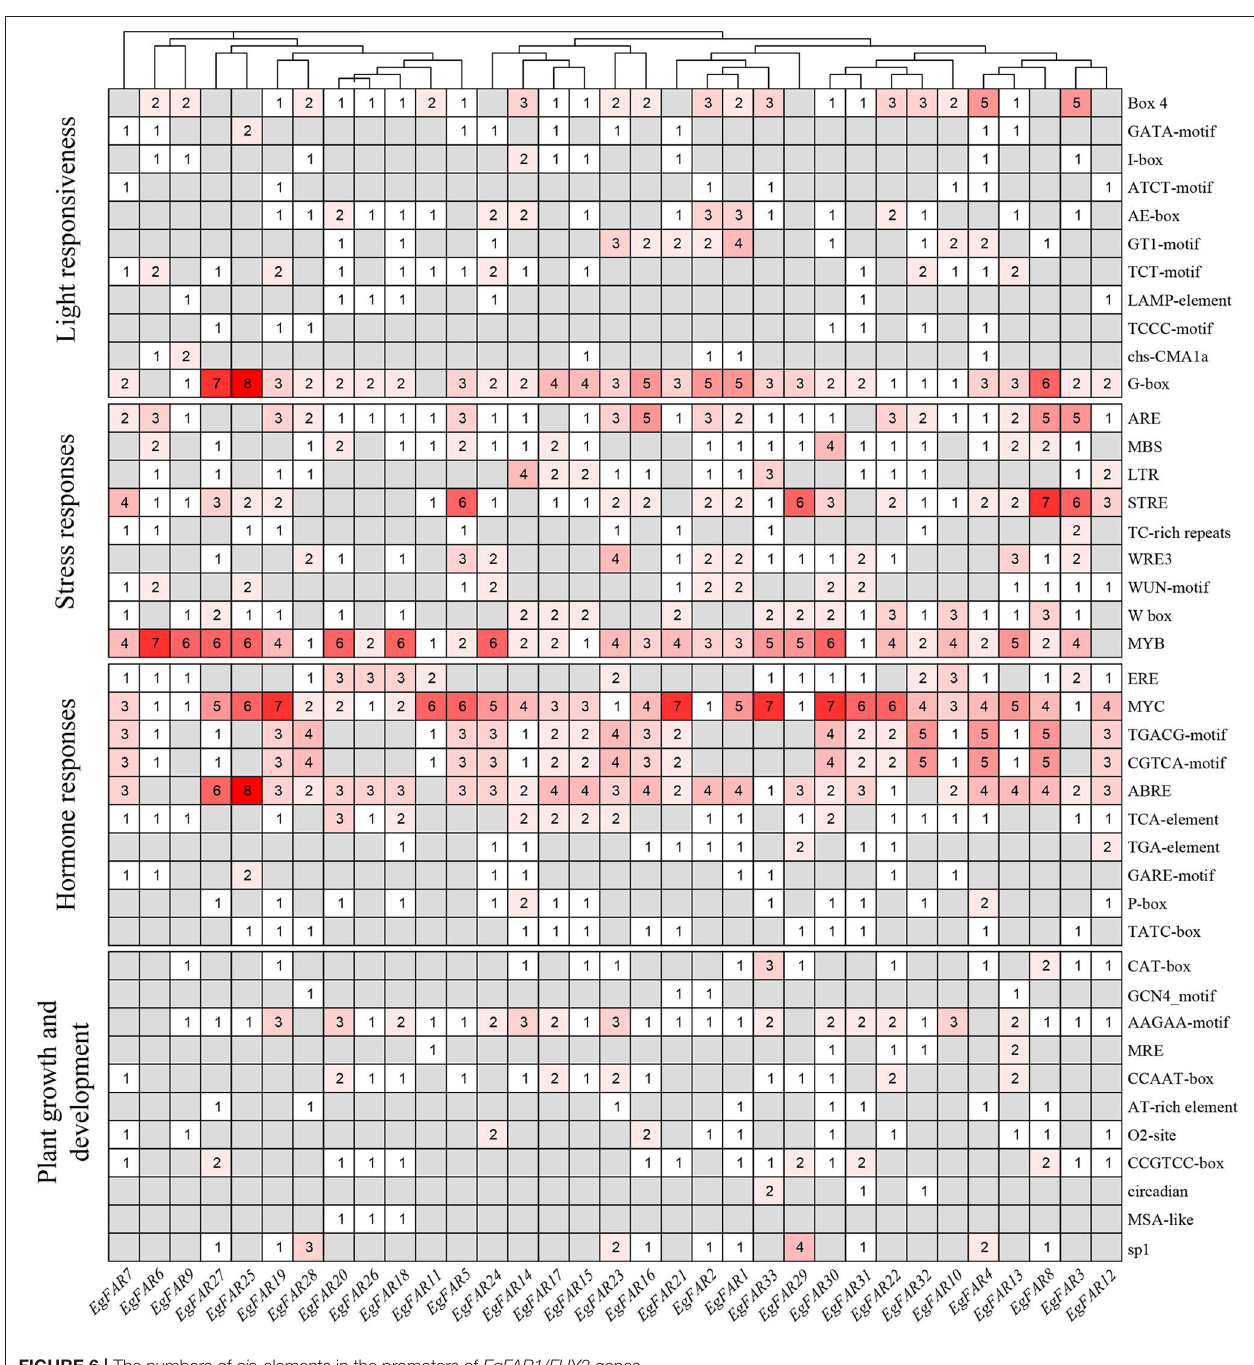
FIGURE 6 | The numbers of cis -elements in the promoters of EgFAR1/FHY3